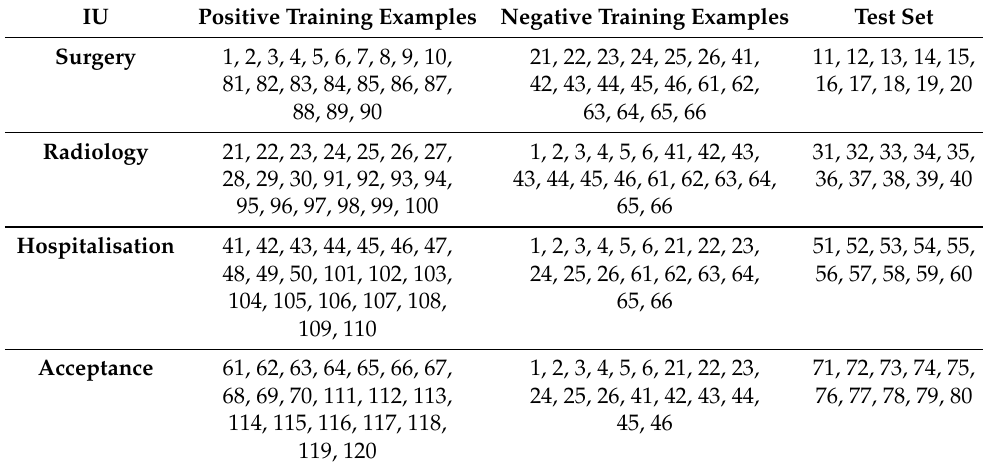
Table 2. Selection of the training set, along with its division into positive and negative examples, and the test set for the second version of the customised model.